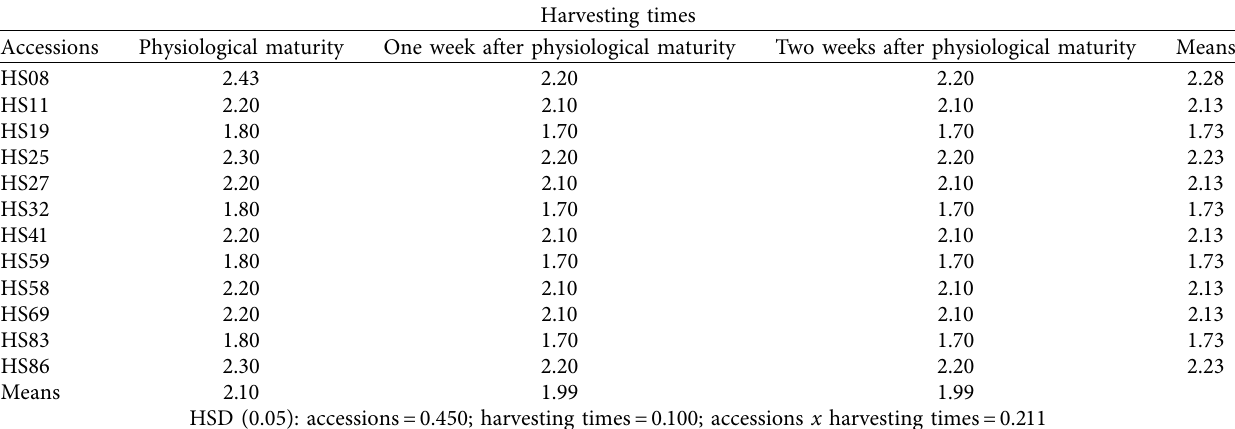
Table 4: Interactive effects of harvesting times x accessions on the seed thickness (mm) of